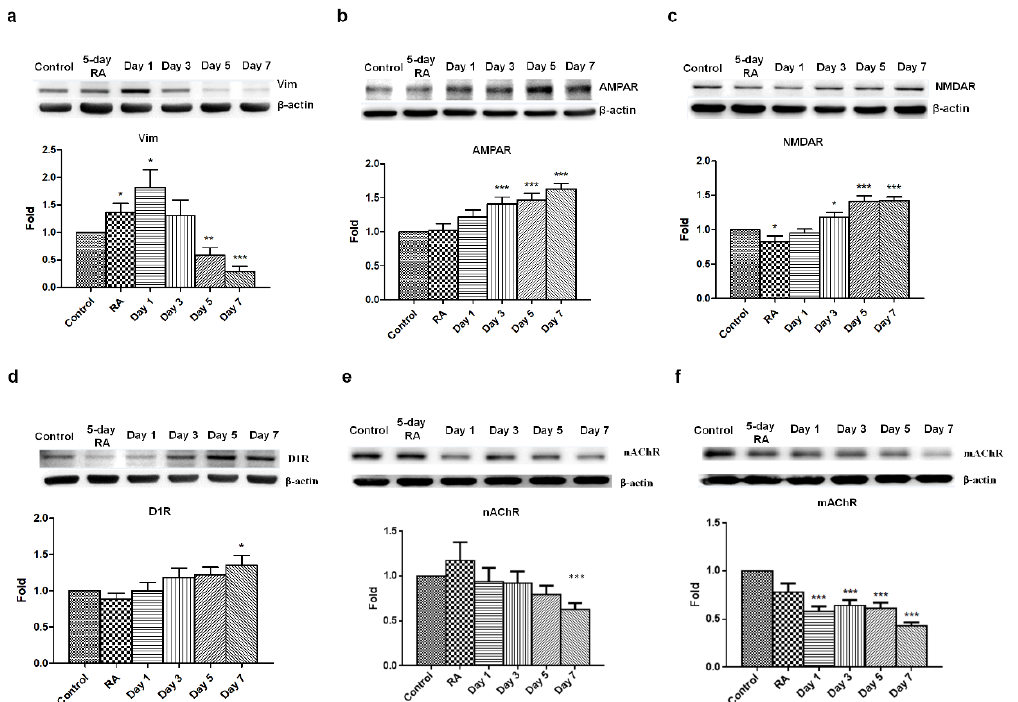
Figure 3. Decreased vimentin expression and promoted AMPA, NMDA, and DA receptors expression in GLP-1-treated SH-SY5Y cells. Immunoblotting results indicated that vimentin (Vim) levels were downregulated in response to shorter GLP-1 treatment durations ( a ). In contrast, the α -amino-3-hydroxy-5-methyl-4-isoxazolepropionic acid receptor (AMPAR, b ), N-methyl-D-aspartate receptor (NMDAR, c ), and dopamine receptor D1 (D1R, d ) were clearly upregulated. Interestingly, both muscarinic acetylcholine receptor (mAChR) and nicotinic acetylcholine receptor (nAChR) were also downregulated during GLP-1 induced di ff erentiation ( e , f ). These results suggested that GLP-1 triggered neuronal di ff erentiation towards glutamatergic and dopaminergic neurons, but not acetylcholinergic neurons. (M ± SD; * p < 0.05; ** p < 0.01; *** p < 0.001; compared to the value of control group, n = 6).